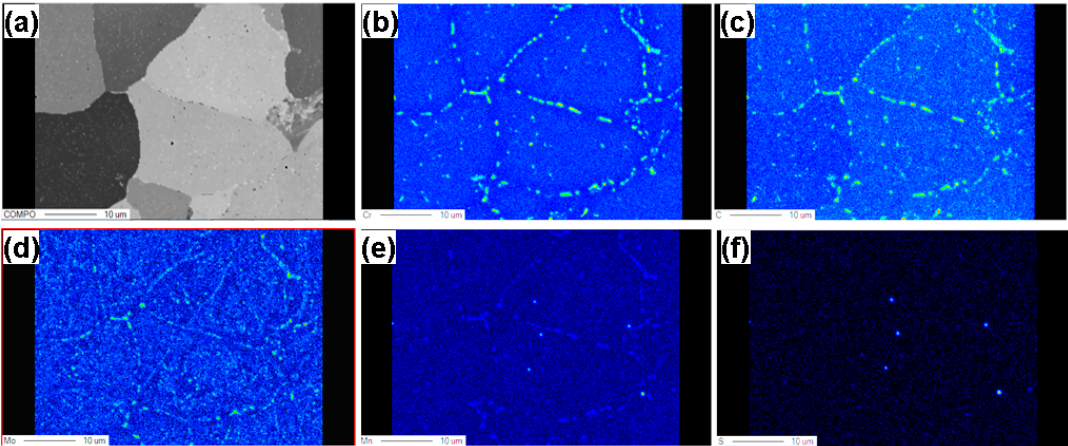
Figure 14. EPMA images of the 28J impact specimen. ( a ) composite image ( b ) chromium ( c ) carbon ( d ) molybdenum ( e ) manganese ( f ) sulfur.